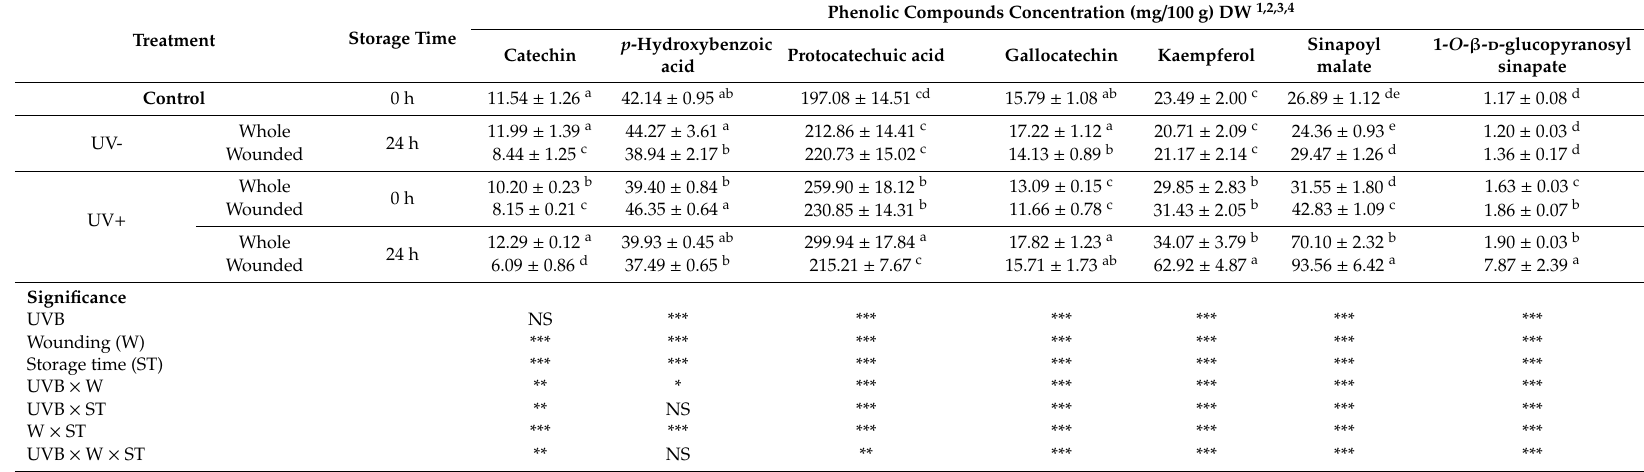
Table 1. Concentration of individual phenolic compounds before and after storage (24 h at 16 ◦ C) of whole and wounded red prickly pear pulp treated with UVB light